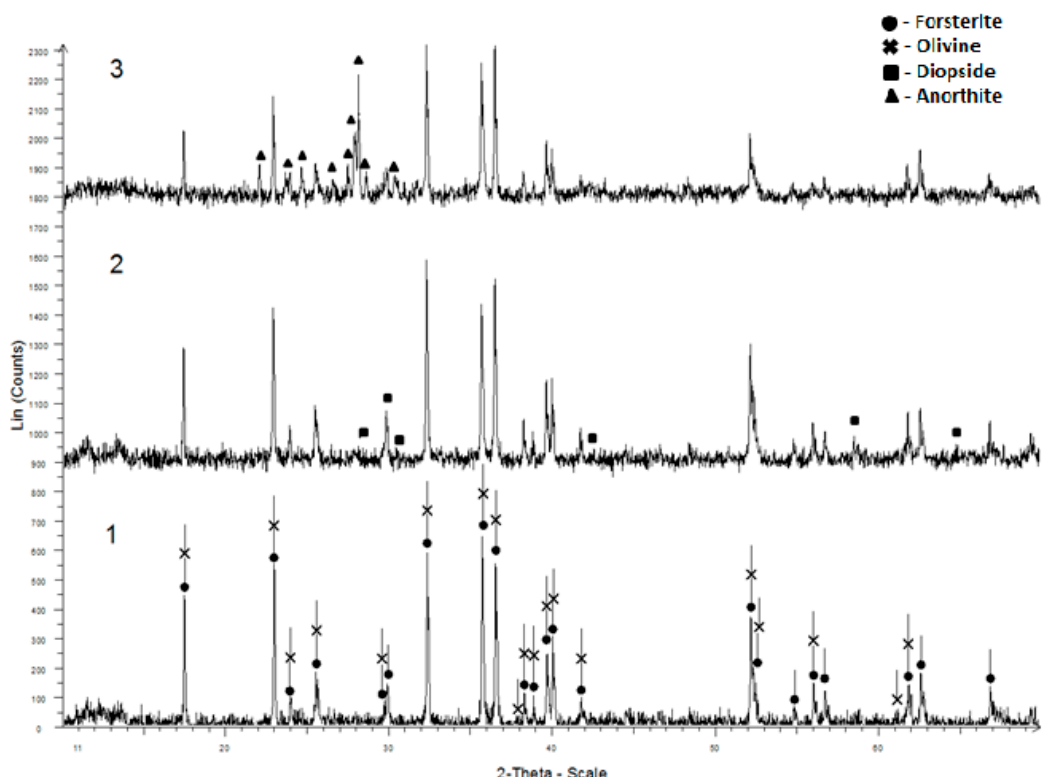
Figure 1. X-ray diffraction pattern of magnesium–silicate rocks: 1—dunite, 2—wehrlite, 3—troctolite. The dunite sand in the X-ray diffraction pattern is represented by olivine and serpen- tine (antigorite and chrysotile) (Figure 2).